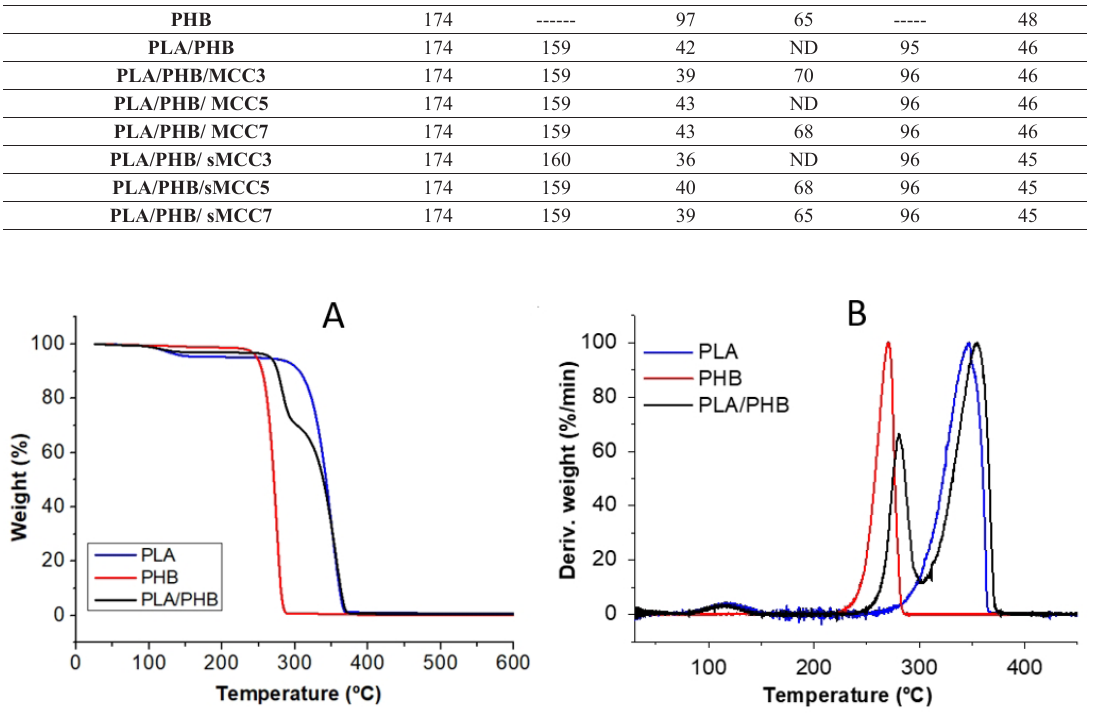
Table 2. Thermal data obtained by DSC for PLA, PHB. PLA/PHB blend and their biocomposites systems. Materials